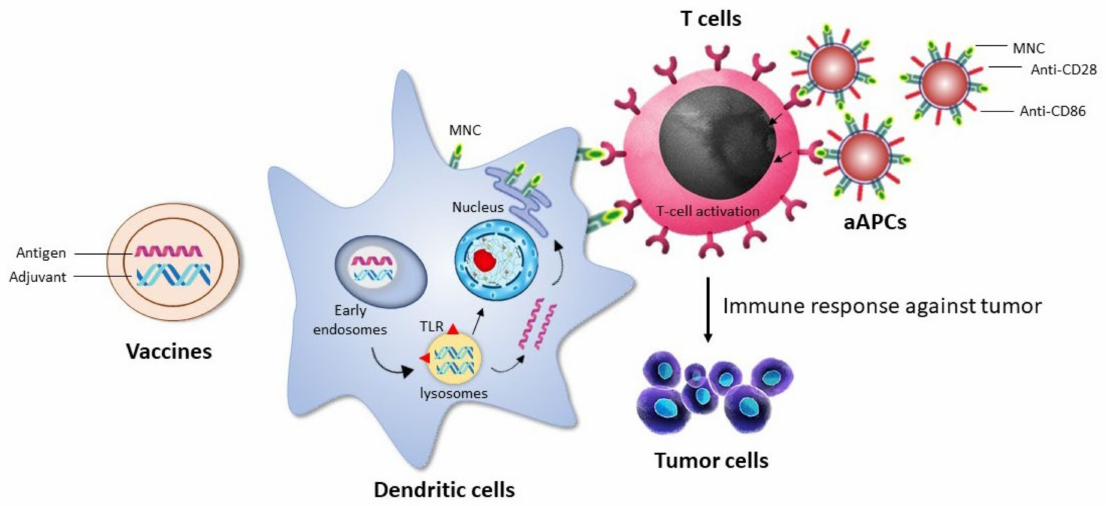
Figure 3. Nanoparticle-based delivery system to activate dendritic cells or T cells for